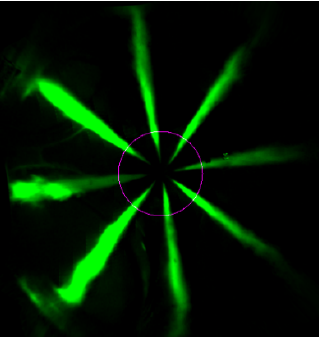
Figure A3. Start position of the circular mask for sampling intensity.